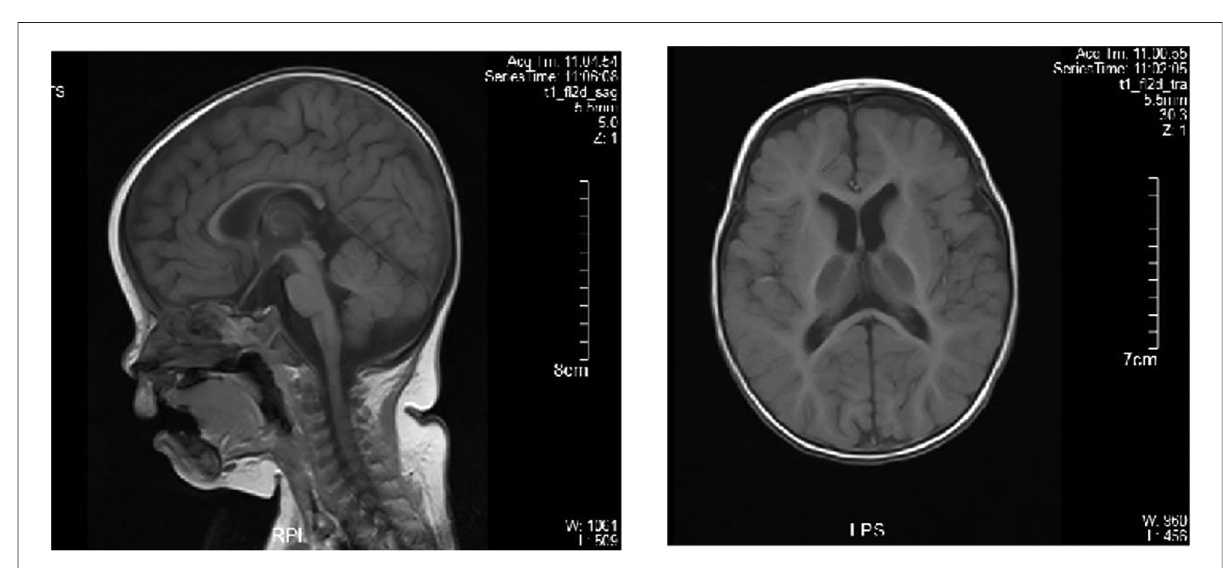
FIGURE 3 Brain MRI of the proband. Brain MRI showed the normal bilateral lateral ventricle and slightly thinner corpus